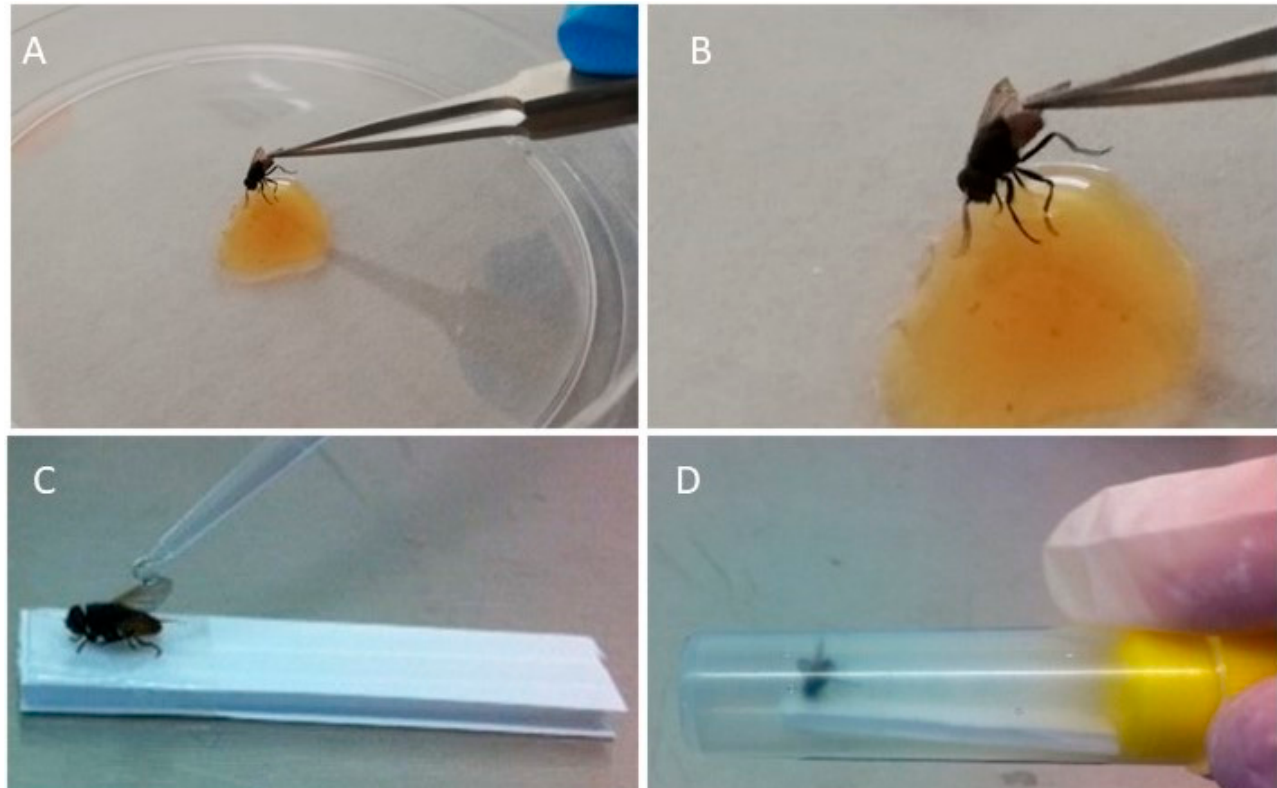
Figure 1. Experiments 1–2: ORFV (from homogenized ovine crusts) contamination of housefly legs ( A , B ) and wings ( C ); housefly during flight motion after wing contamination ( D ).